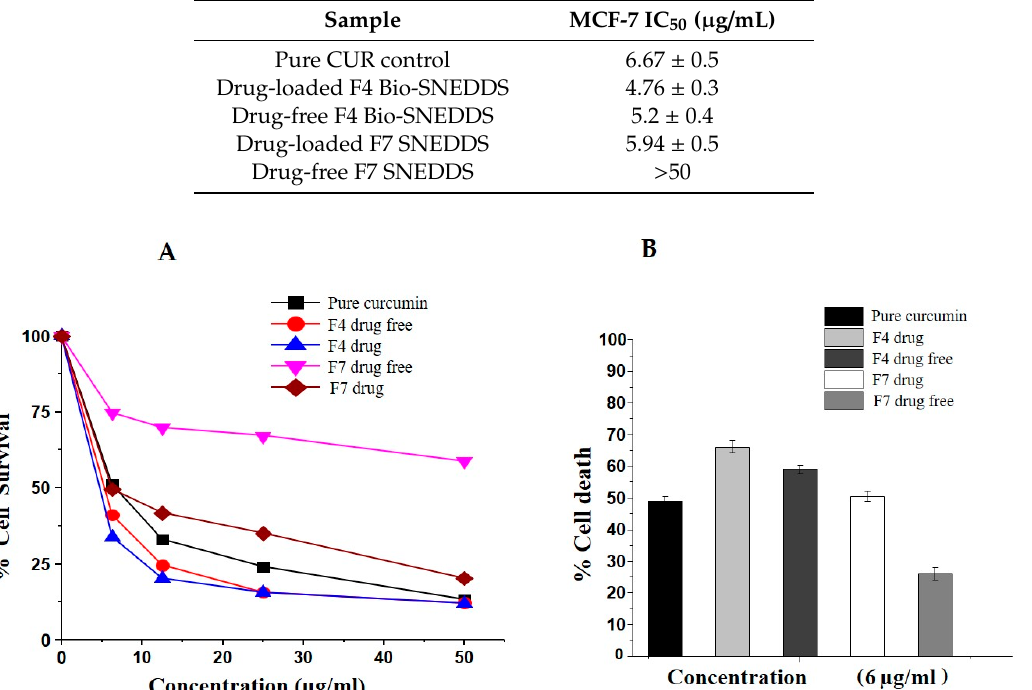
Figure 10. Effect of formulations on MCF-7 cell viability determined by MTT assay. ( A ) MCF-7 cells treated with various concentrations (0, 6, 12.5, 25, and 50 μ g/mL) for 48 h. ( B ) The percentage of cell death after treatment with 6 μ g/mL of each formulation. Data are expressed as the mean ± SD of three independent experiments. Table 5. The effect of the MTT assay on the formulations to evaluate IC 50 (the concentration that kills 50% of cells).